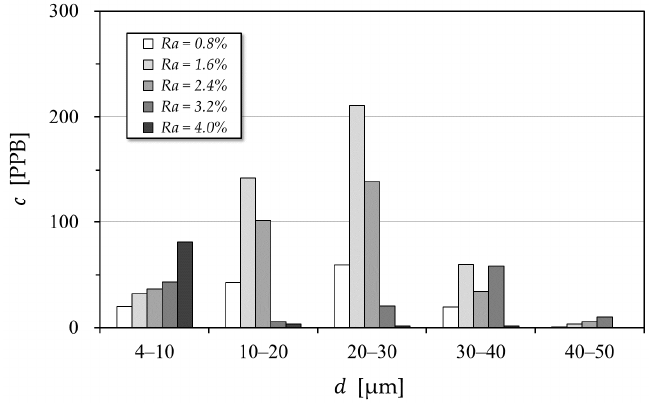
Figure 7. Bubble concentrations at the pump pressure of 6 bar.